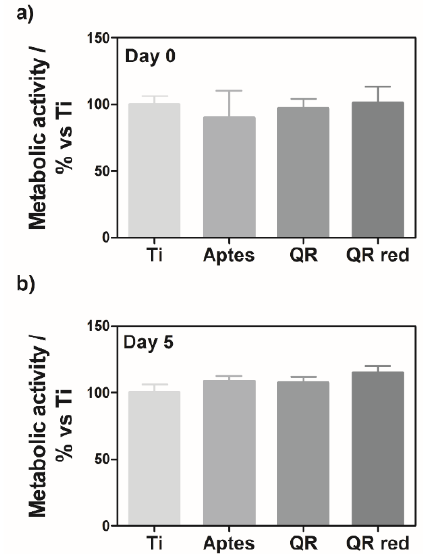
Figure 2. Metabolic activity of RAW264.7 cells cultured on quercitrin coated Ti surfaces was measured at ( a ) day 0 and ( b ) day 5 with a resazurin-based assay (PrestoBlue Cell Viability Reagent). Values represent mean ± SEM, n = 6. No significant differences were found between groups as compared by Student- t -test.